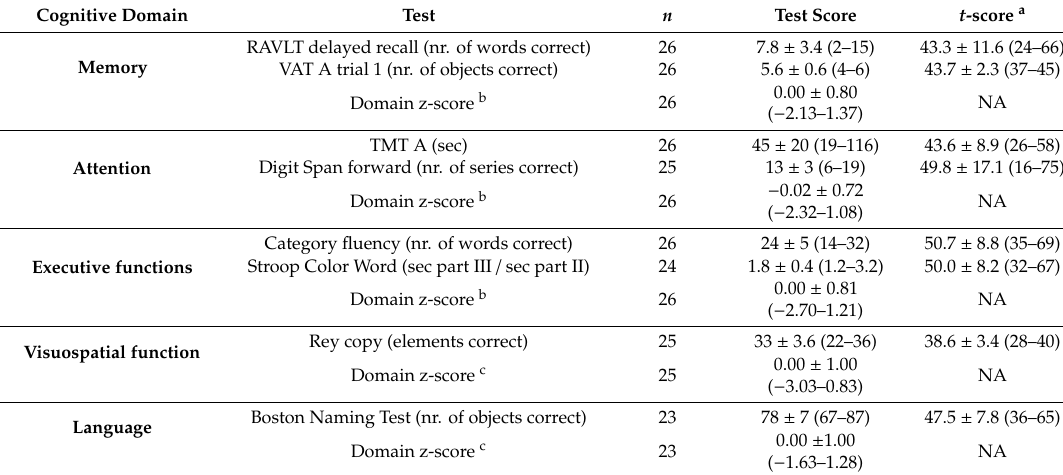
Table 2. Neuropsychological test scores and cognitive domain